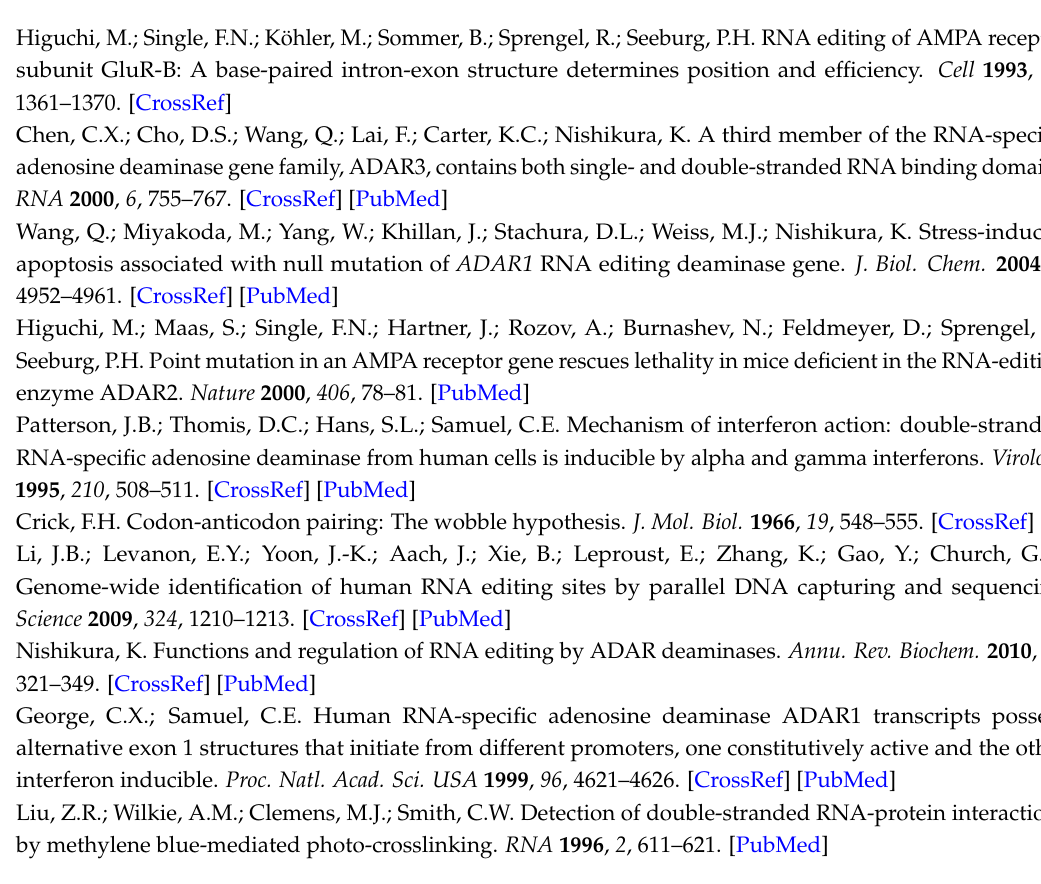
Figure S1: Statistics on the RNA-seq data sets for differential expression analysis, Table S1: List of differentially expressed genes, Table S2: List of ADAR-bound candidates detected by